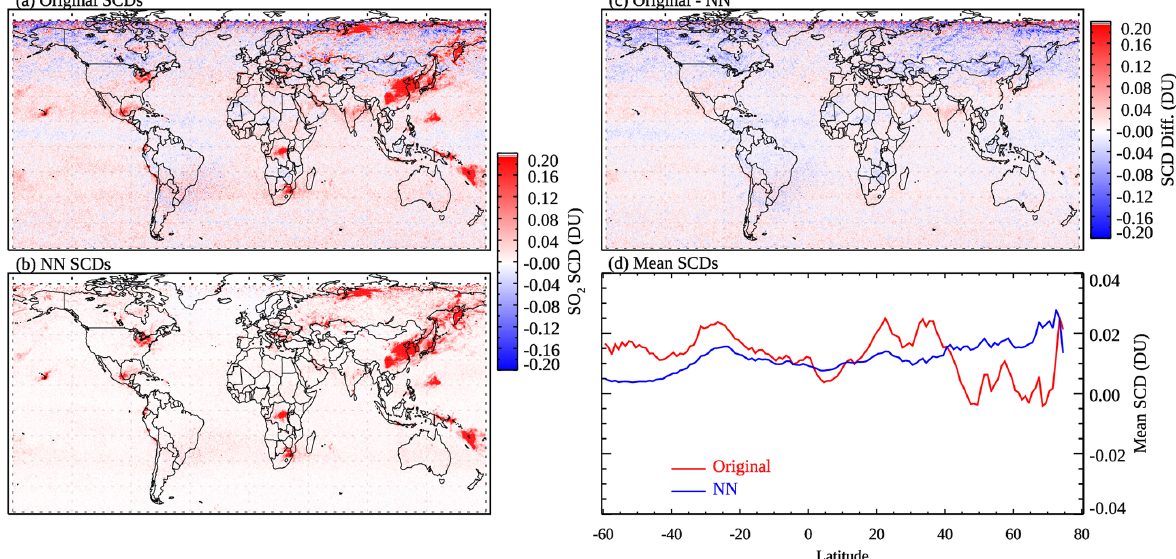
Figure 5. Similar to Fig. 4 but showing monthly means for March 2005.